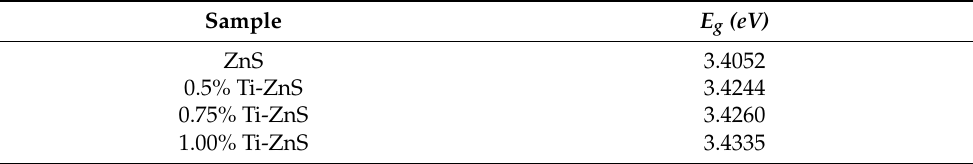
Table 2. Energy band gap.